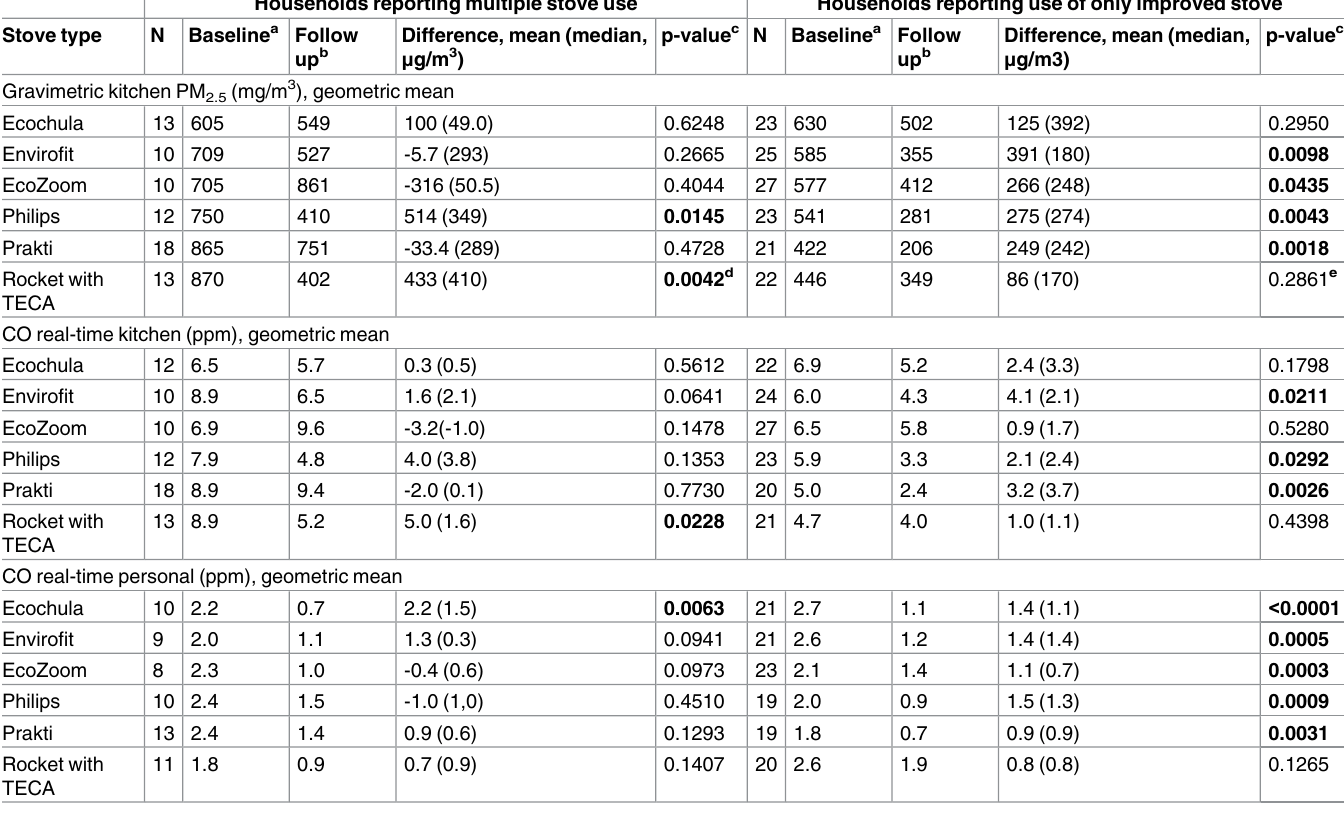
Table 6. Gravimetric PM 2.5 ( μ g/m 3 ) and kitchen and personal (woman) CO real time (ppm) 48-hour concentration by stove type, stratified by reported multiple stove